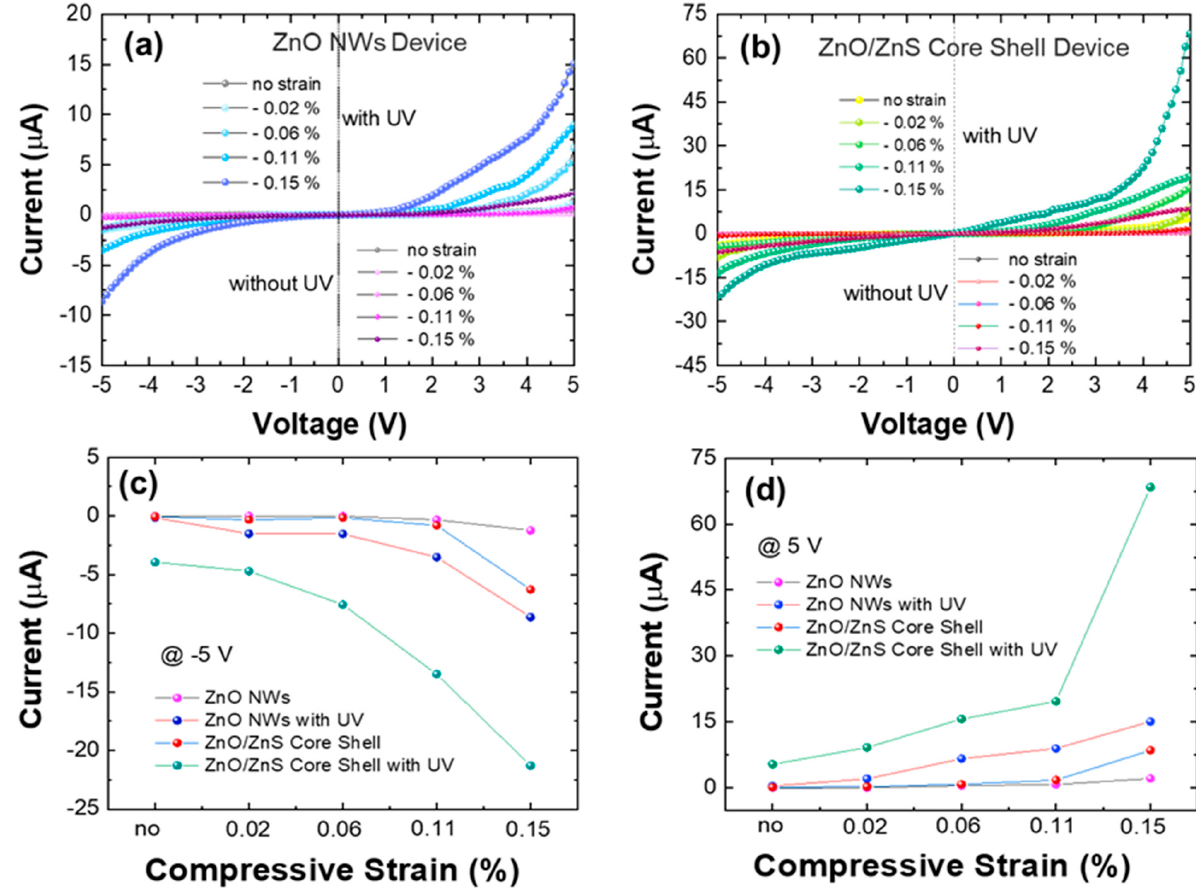
Figure 4. Typical I – V curves of ( a ) ZnO and ( b ) ZnO/ZnS core/shell NWs under dark condition and 365 nm UV illumination (0.78 mW/cm 2 ) as the compressive strain changes from 0 to − 0.15%. Dark current and photocurrent of the ZnO and ZnO/ZnS core/shell NWs as a function of the compressive strain at applied biases of ( c ) − 5 V and ( d ) 5 V.